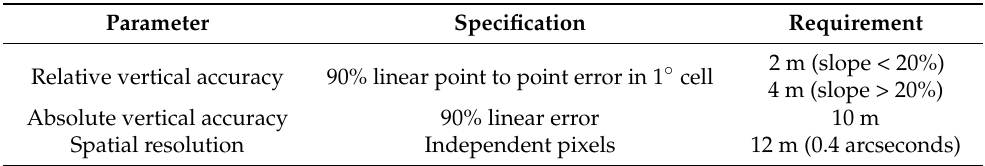
Table 1. Primary objective of the TanDEM-X mission [13]. Parameter Specification Requirement Relative vertical